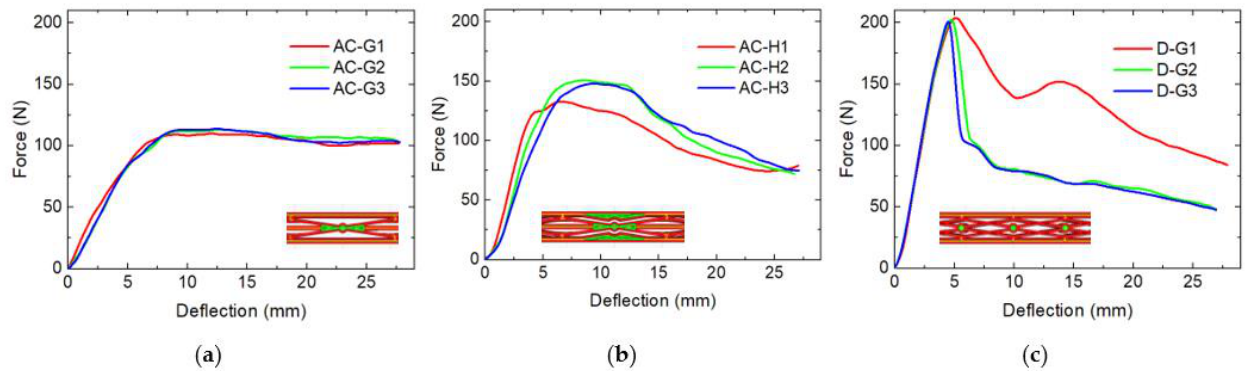
Figure 2. Maximum bending tests of the improved set of samples: ( a ) specimens AC-G; ( b ) specimens AC-H; ( c ) specimens D-G.